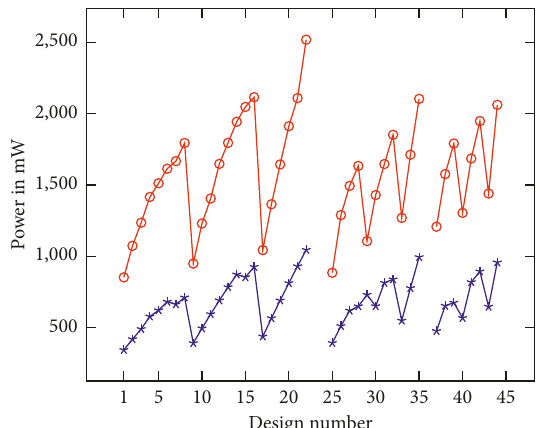
Figure 10: The estimation percentage error for frame execution time when compared to the measured values.